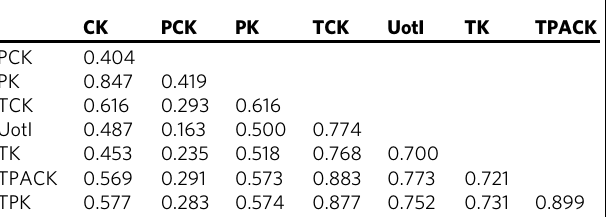
Table 4 HTMT < 0.900.